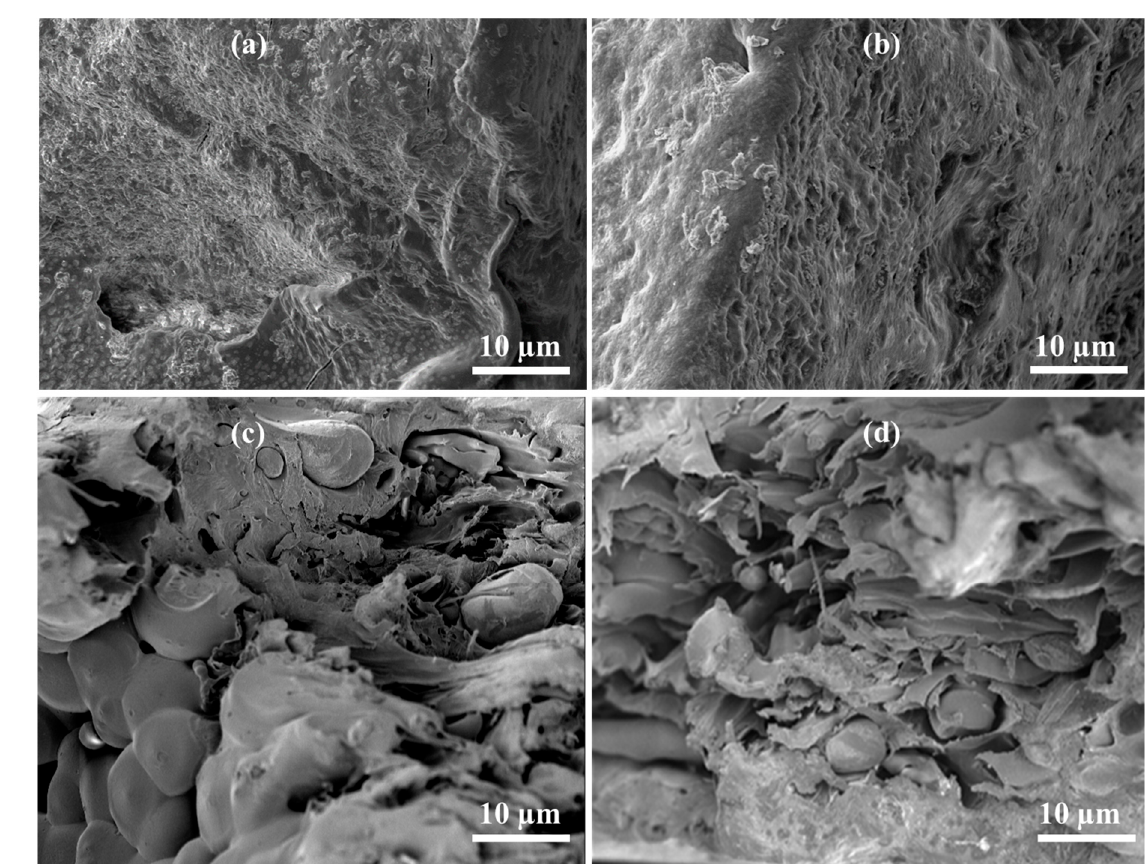
Figure 2. The morphology of the hydrogel interior of ( a ) pristine GelMA, ( b ) NCST1, ( c ) NCST2, and ( d ) NCST3, respectively.